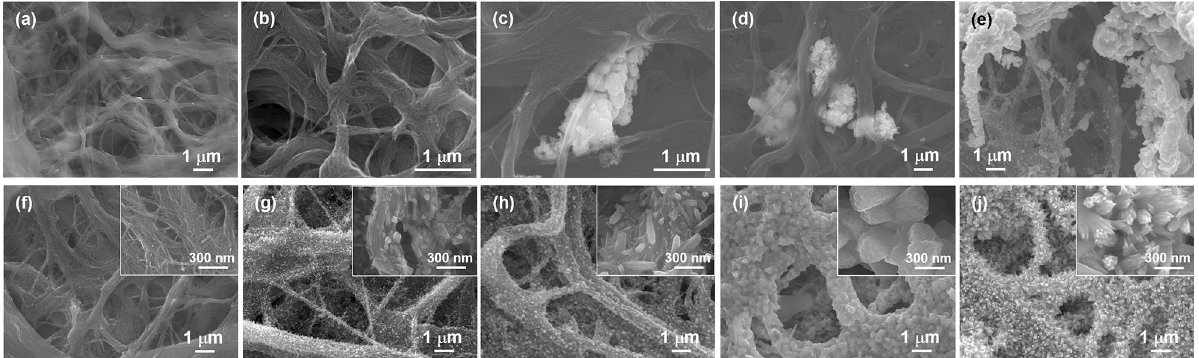
Figure 3. Surface SEM images of SWCNT films with different quantities of nanoparticles and excluding electrodeposition: ( a ) no nanoparticles, ( b ) 5 mg, ( c ) 10 mg, ( d ) 50 mg, and ( e ) 100 mg. Surface SEM images of SWCNT films with different quantities of nanoparticles and with electrodeposition: ( f ) no nanoparticles, ( g ) 5 mg, ( f ) 10 mg, ( i ) 50 mg, and ( j ) 100